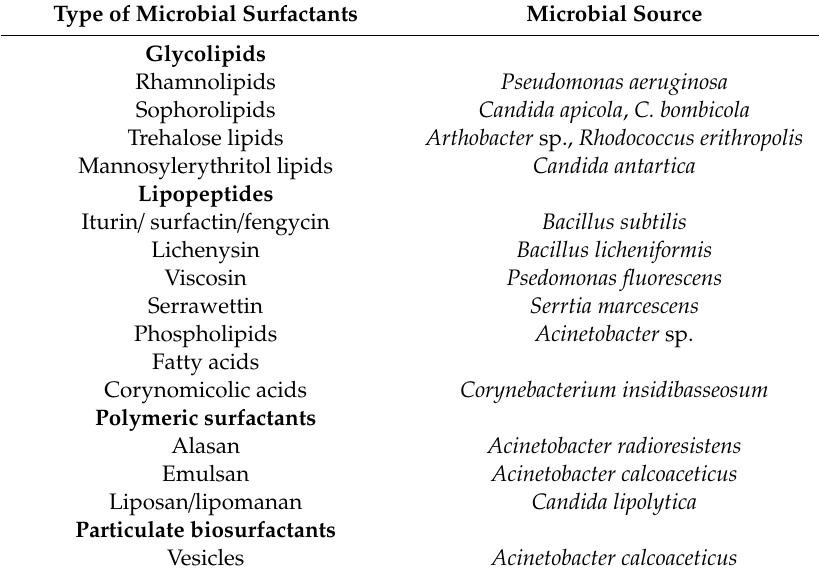
Table 1. Major classes of microbial surfactants and their microbial source. Type of Microbial Surfactants Microbial